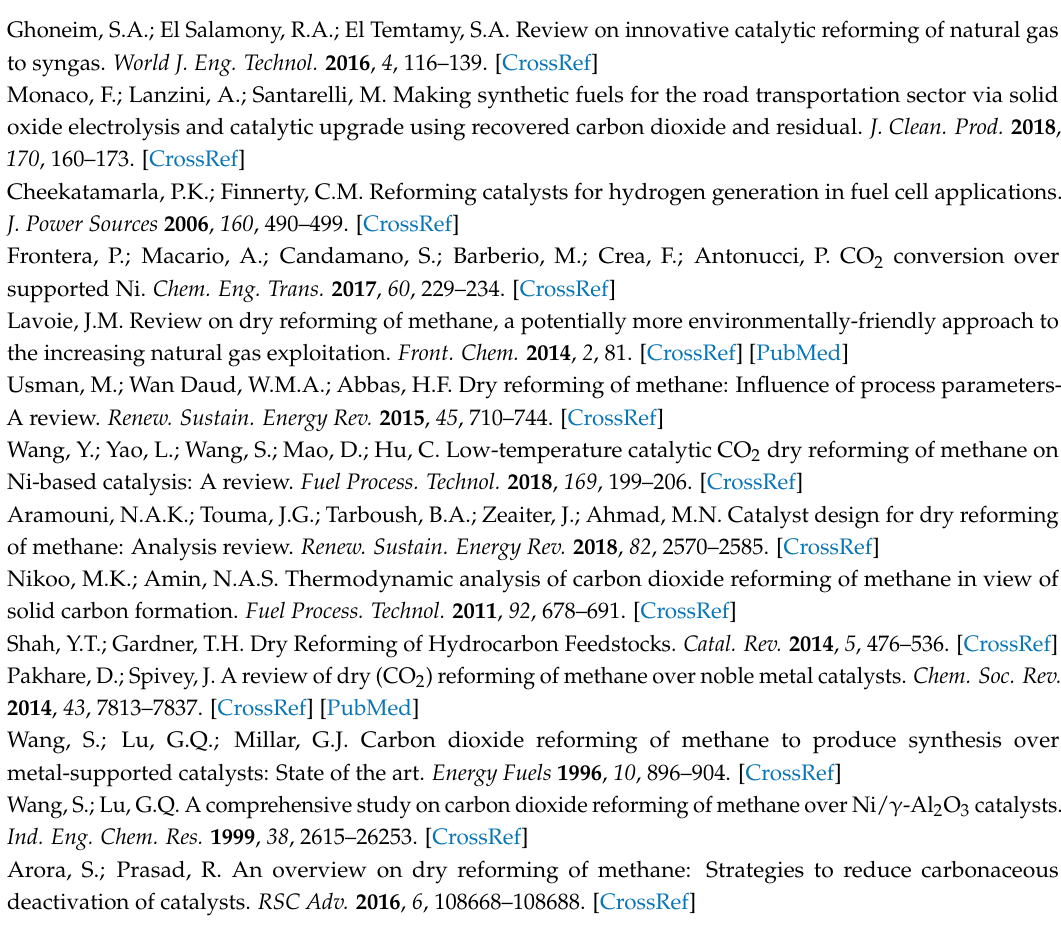
Figure S1: TPR of supports prepared with a different surfactant/cations molar ratio, Figure S2: XRD of Ni catalysts; the black dot indicates NiO phase, Figure S3: Endurance test at 650 ◦ C, (A) methane conversion, (B) CO 2 conversion, (C) S/C ratio, Table S1: XRD identified